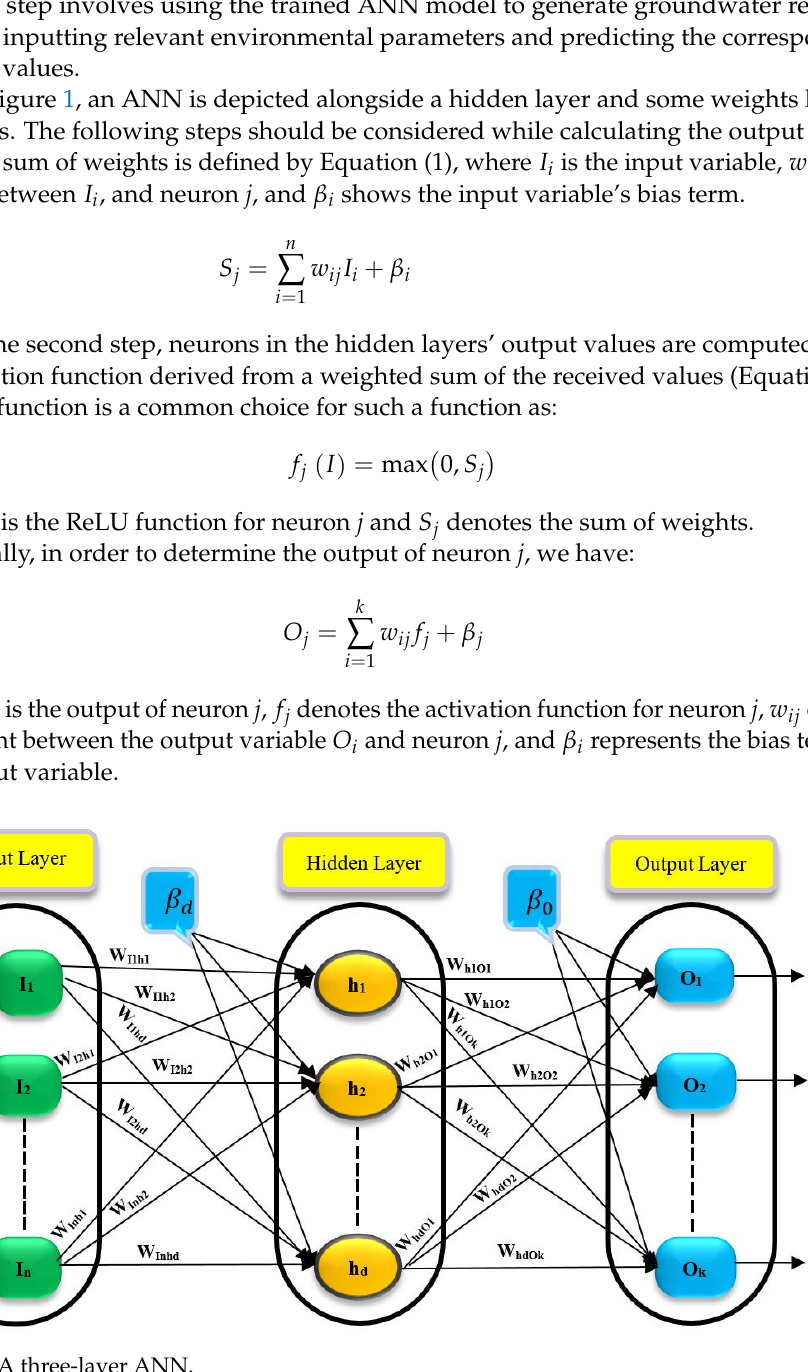
Figure 1. A three-layer ANN.